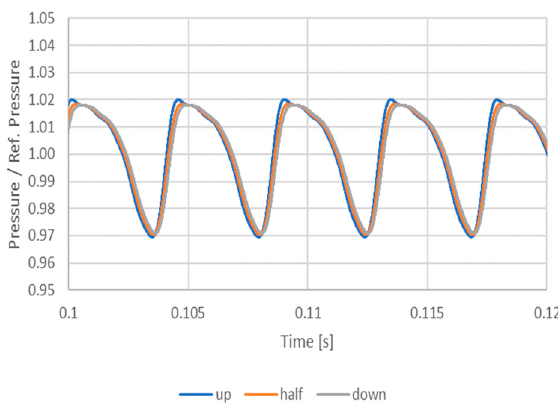
Figure 5. Pressure evolution in different pipe sections with the damper inactive, pump speed = 1500 rpm.